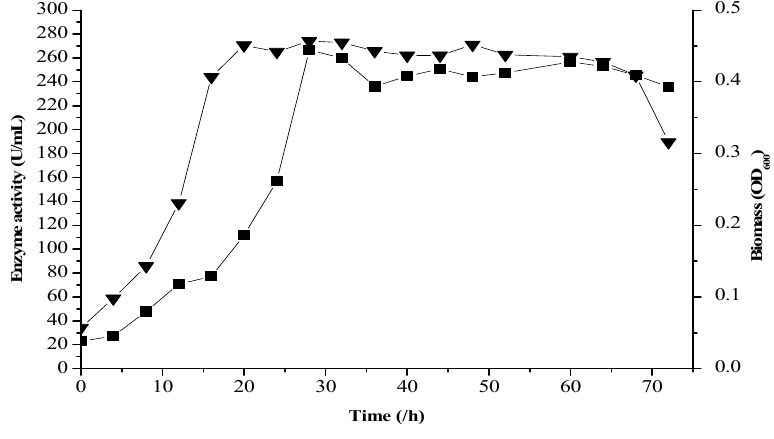
(cid:72) ) and enzyme activity ( (cid:4) ) curve of strain Thalassospira sp. Figure 6. The cell growth ( ▼ ) and enzyme activity ( ■ ) curve of strain Thalassospira sp. fjfst-332. Figure 6. The cell growth (